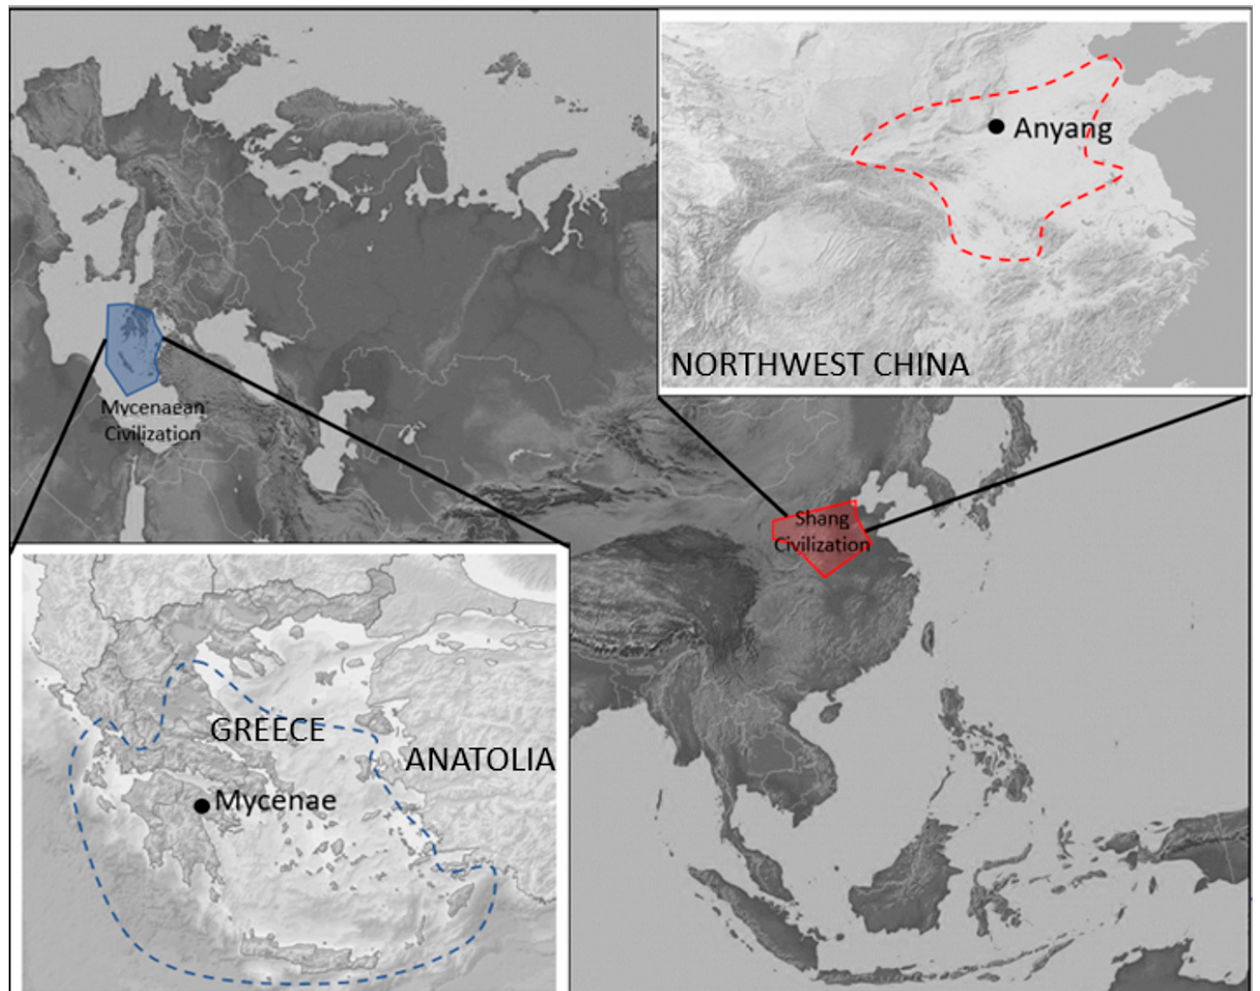
Figure 1. Approximate Mycenaean and Shang territories (Based on [8,9] (basemap free source: https://geology.com/world/asia-physical-map.shtml (access on 10 June 2022)).